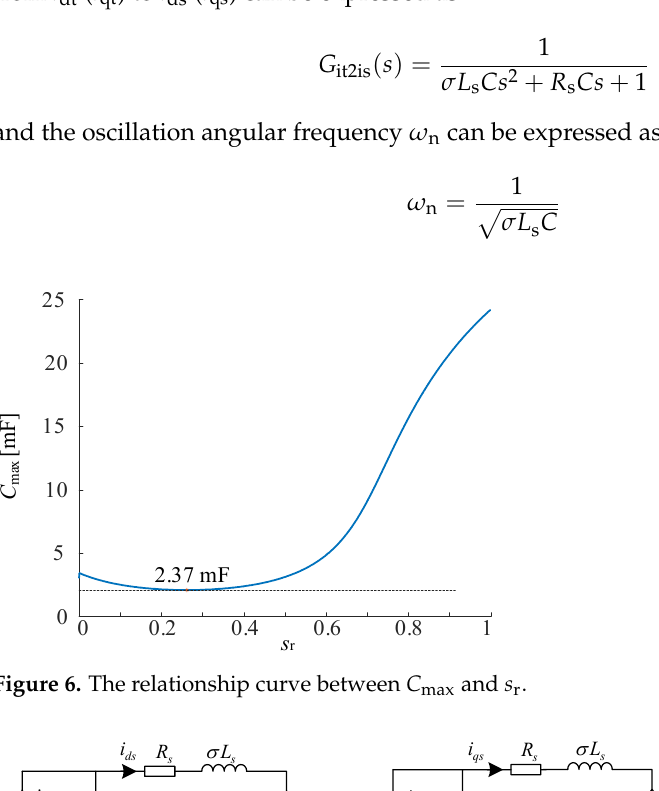
Table 2. The parameters of the IM.